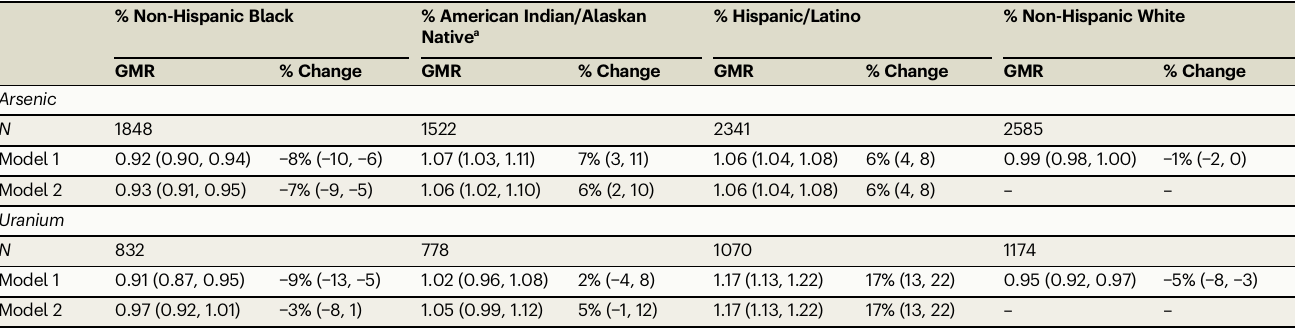
SpatialautocorrelationwasmodeledinLagrangemodelswithautoregressivecorrelationstructure.County-levelCWSarsenicanduraniumwerenaturallog-transformedforanalysis.Model1adjusts forpopulationdensity,thepercentofpublicwatersourcesfromgroundwatersupplies,medianhouseholdincomeandthepercentofadultswithahighschooldiploma.Model2furtheradjustsfor theracial/ethnic compositionofother racial/ethnic groups, exceptnon-HispanicWhite (leave-one-outmodel). Coef fi cientsforthe spatial lag termweresigni fi cantinallmodels. a Sensitivityanalyses not adjusting for population densityyielded similar fi